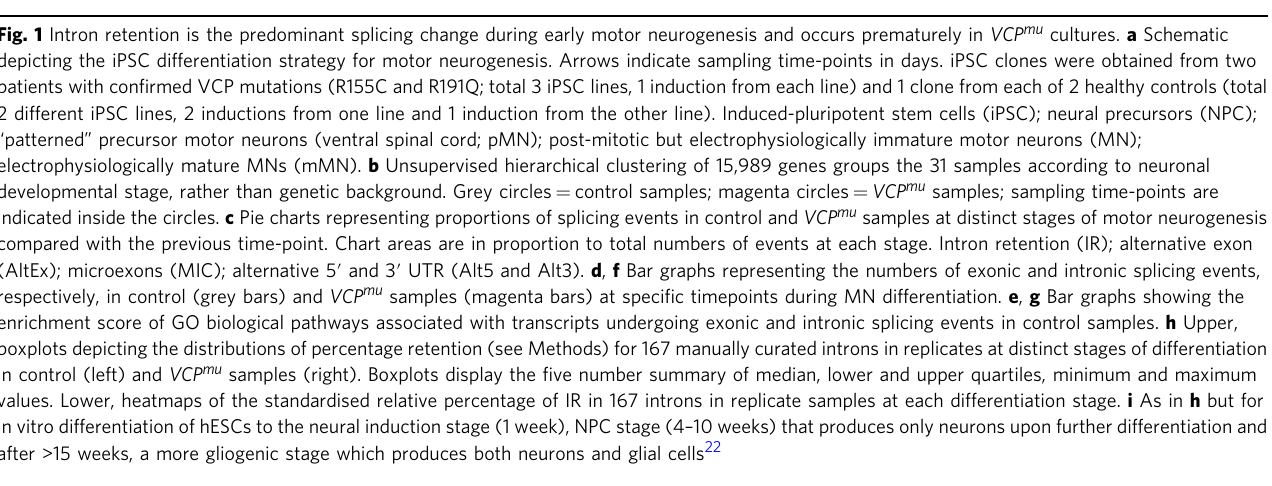
Fig. 1 Intron retention is the predominant splicing change during early motor neurogenesis and occurs prematurely in VCP mu cultures. a Schematic depicting the iPSC differentiation strategy for motor neurogenesis. Arrows indicate sampling time-points in days. iPSC clones were obtained from two patients with con fi rmed VCP mutations (R155C and R191Q; total 3 iPSC lines, 1 induction from each line) and 1 clone from each of 2 healthy controls (total 2 different iPSC lines, 2 inductions from one line and 1 induction from the other line). Induced-pluripotent stem cells (iPSC); neural precursors (NPC); “ patterned ” precursor motor neurons (ventral spinal cord; pMN); post-mitotic but electrophysiologically immature motor neurons (MN); electrophysiologically mature MNs (mMN). b Unsupervised hierarchical clustering of 15,989 genes groups the 31 samples according to neuronal developmental stage, rather than genetic background. Grey circles = control samples; magenta circles = VCP mu samples; sampling time-points are indicated inside the circles. c Pie charts representing proportions of splicing events in control and VCP mu samples at distinct stages of motor neurogenesis compared with the previous time-point. Chart areas are in proportion to total numbers of events at each stage. Intron retention (IR); alternative exon (AltEx); microexons (MIC); alternative 5 ′ and 3 ′ UTR (Alt5 and Alt3). d , f Bar graphs representing the numbers of exonic and intronic splicing events, respectively, in control (grey bars) and VCP mu samples (magenta bars) at speci fi c timepoints during MN differentiation. e , g Bar graphs showing the enrichment score of GO biological pathways associated with transcripts undergoing exonic and intronic splicing events in control samples. h Upper, boxplots depicting the distributions of percentage retention (see Methods) for 167 manually curated introns in replicates at distinct stages of differentiation in control (left) and VCP mu samples (right). Boxplots display the fi ve number summary of median, lower and upper quartiles, minimum and maximum values. Lower, heatmaps of the standardised relative percentage of IR in 167 introns in replicate samples at each differentiation stage. i As in h but for in vitro differentiation of hESCs to the neural induction stage (1 week), NPC stage (4 – 10 weeks) that produces only neurons upon further differentiation and after >15 weeks, a more gliogenic stage which produces both neurons and glial cells